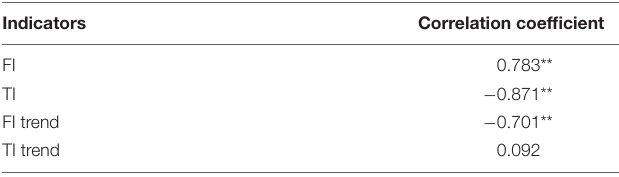
TABLE 3 | The Pearson correlation coefficients of elevation and FI and TI and their changing trends. Indicators Correlation coefficient